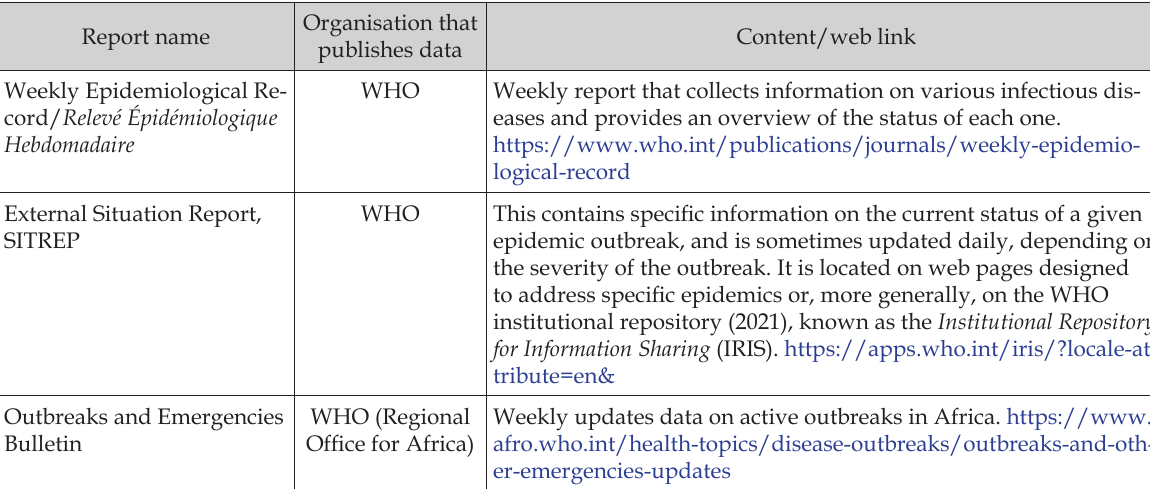
Table 1. WHO bulletins consulted for locating Ebola